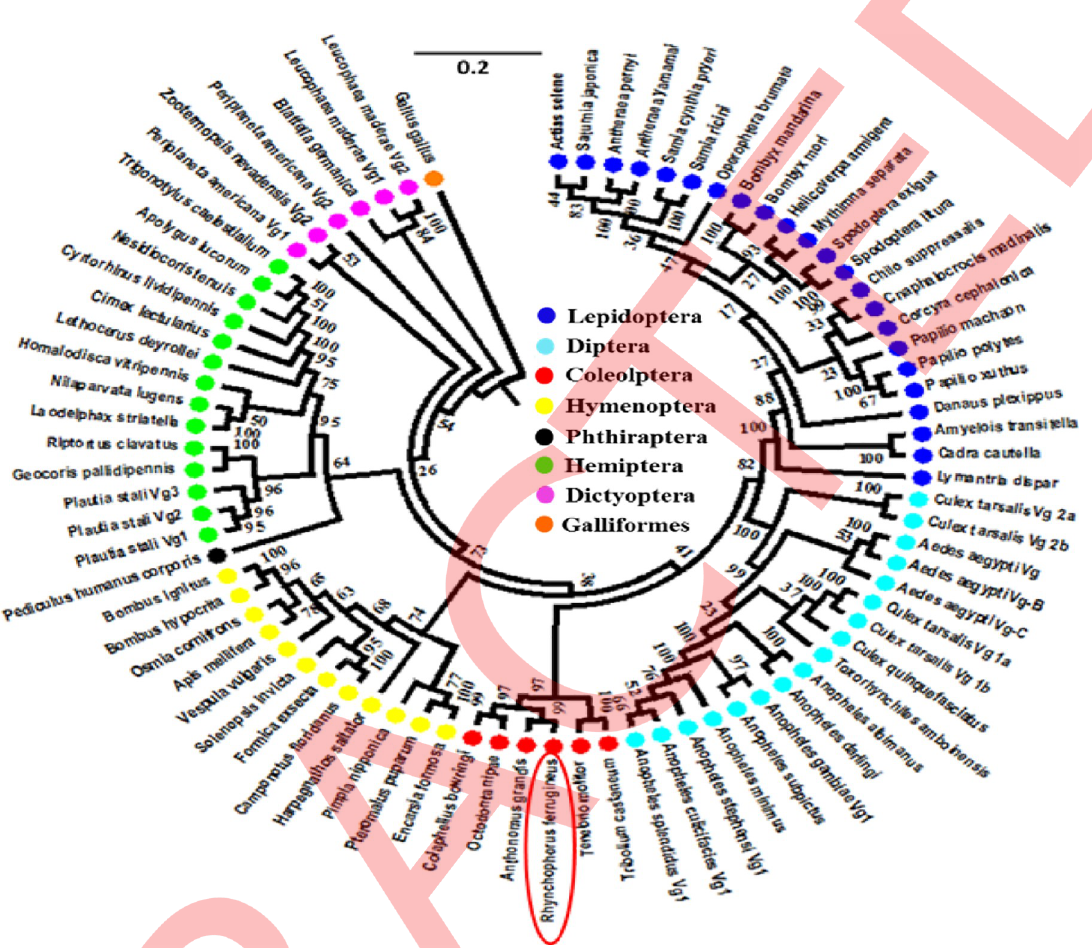
Fig 13. Neighbor-joining phylogenetic tree of 80 insect Vgs representing 7 orders. The amino acid sequences were aligned using the ClustalW program and used as input for a neighbor-joining tree construction program (MEGA6) (Tamura et al. 2013). Scale 0.2 indicates distance (number of amino acid substitutions per site). Species belonging to different orders are indicated with bolls of different colors. Gallus gallus (representing galliformes) Vg was used as an out-group.